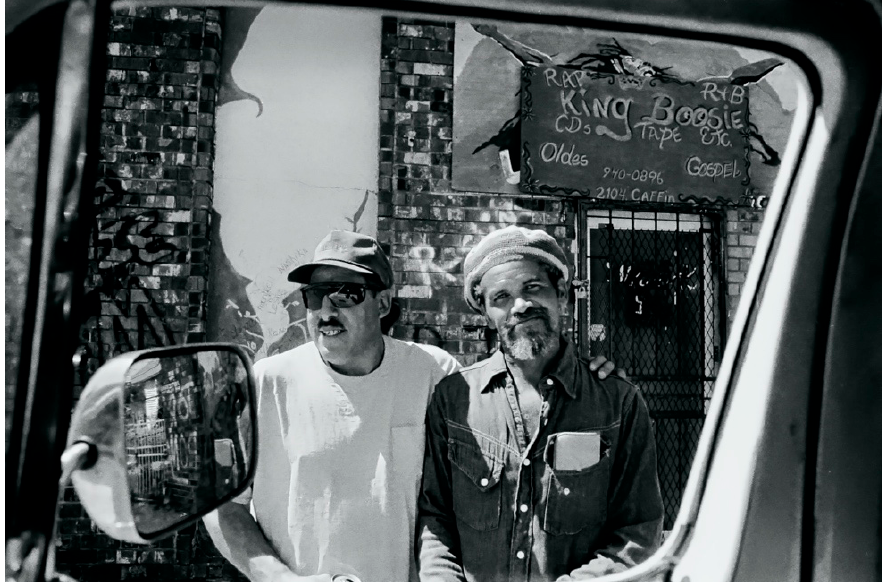
Figure 19. Monique Verdin’s father, Michelle Verdin, with his friend John Taylor in the Lower Ninth Ward of New Orleans in the late 1990s. Photograph by Monique Verdin.